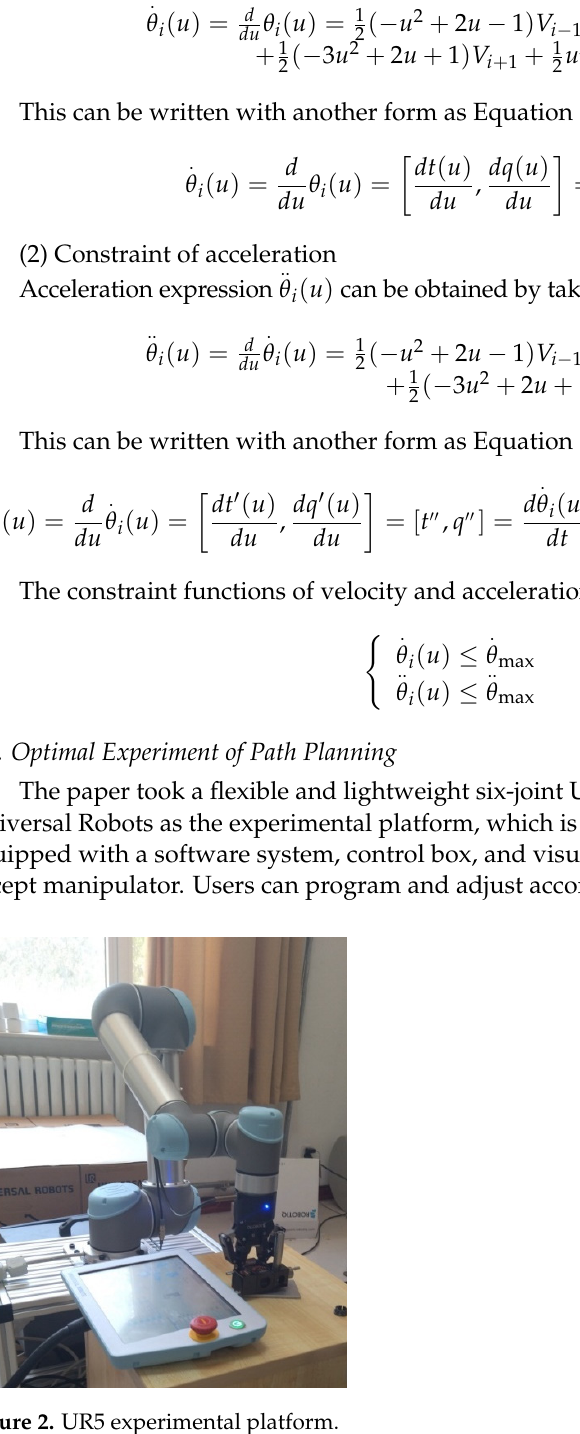
Table 4. Sequence of joint’s positions.